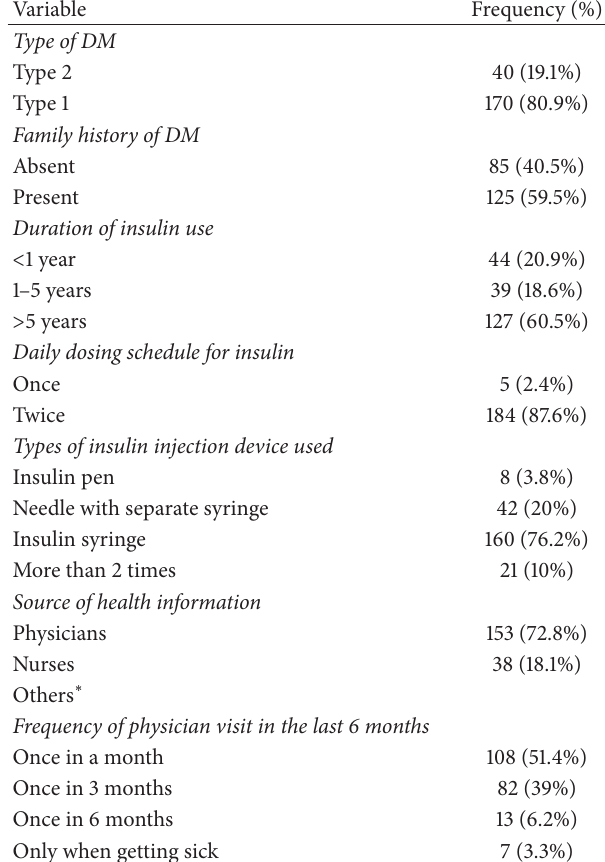
Table 1: Sociodemographic characteristics of respondents, Gondar, 2016.